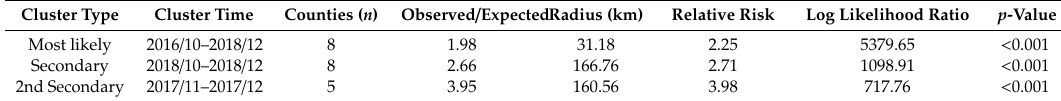
Figure 6. Spatial-temporal cluster map of varicella in Chongqing, 2014 to 2018. Table 4. Results for space-time clusters of varicella in Chongqing from 2014 to 2018.